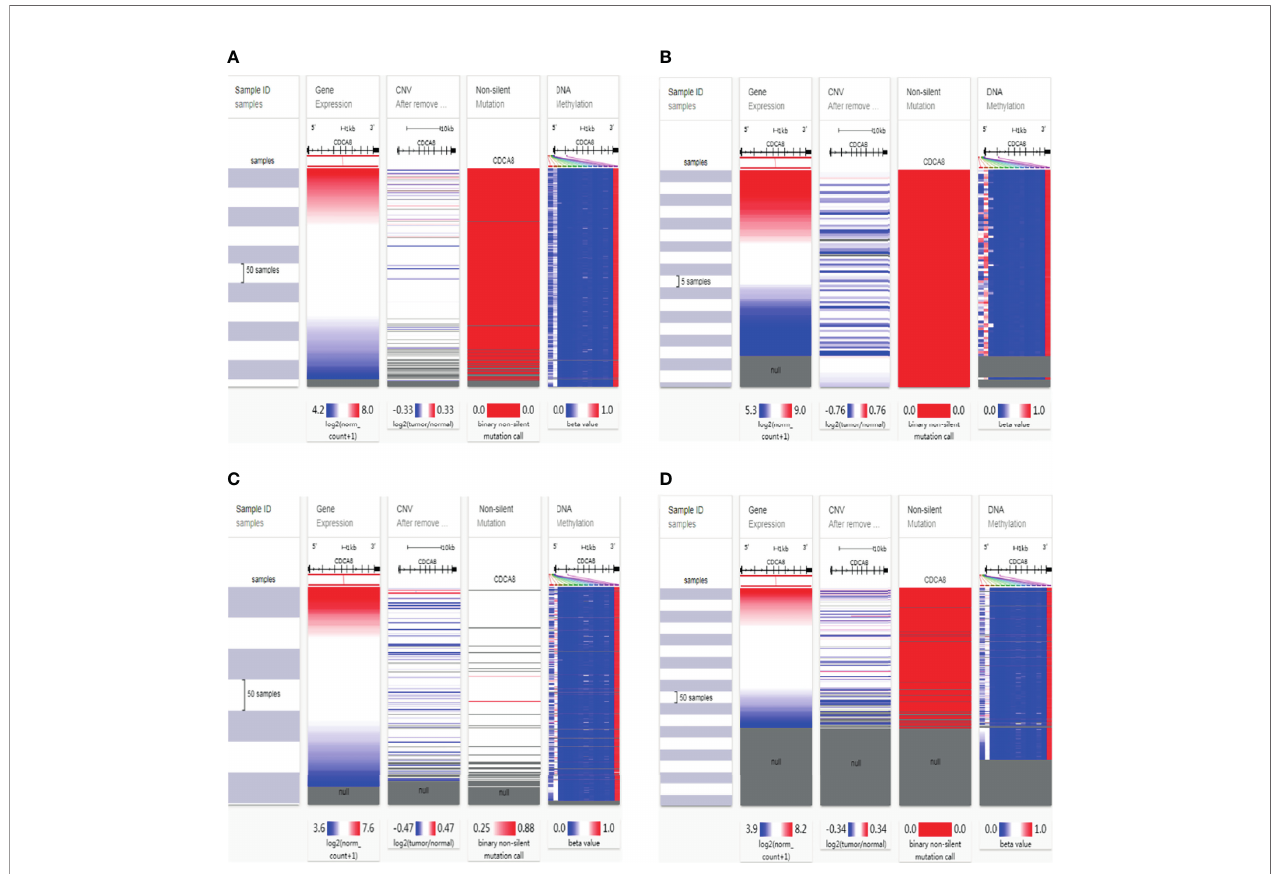
FIGURE 2 | Mutation, Copy Number Variation, and Methylation Analysis of CDCA8. CNV, DNA methylation and somatic mutations in PCa (A) , ACC (B) , KIRP (C) and KIRC (D)